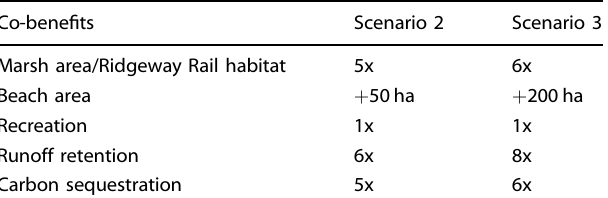
Table 1. Changes in habitat and ecosystem services provided by Scenario 2 ( ‘ What we are doing ’ ) and Scenario 3 ( ‘ What we could do next ’ ) relative to the engineered baseline ( ‘ What we might have done ’ ) without investing in nature-based